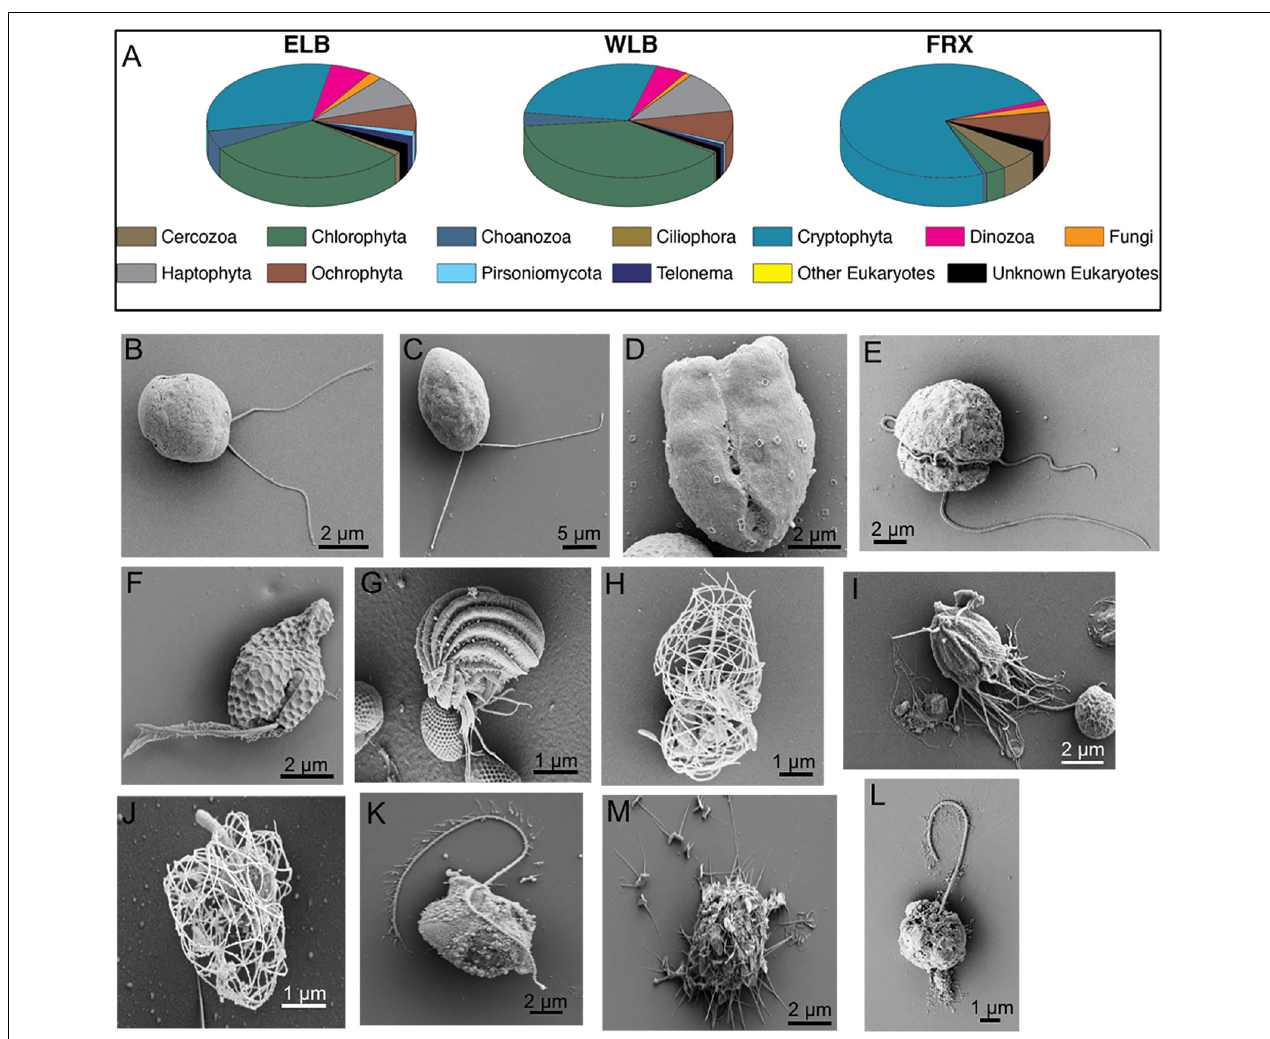
FIGURE 2 | Phylogenetic and morphological diversity of microbial eukaryotes communities residing in the water columns of the east and west lobes of Lake Bonney (ELB and WLB, respectively) and Lake Fryxell (FRX). (A) Phylogenetic diversity based on 18S rRNA gene sequences integrated within the whole water column of individual lakes. (B–M) Representative SEMs of key protists residing in the MDV lakes. B , Haptophyta, Isochrysis sp. (ELB,WLB); C , Chlorophyta, Chlamydomonas sp. (ELB, WLB); D , Chlorophyta, prasinophyte (ELB); E , Dinozoa (ELB); F , Cryptophyta, Geminigera sp. (FRX); G , Ciliophora, Euplotes sp. (FRX); H–J , Choanozoa (ELB, WLB); K,M , Ochrophyta, Chrysophytes (ELB, WLB); L , Personiomycota, Personia , sp. (ELB,